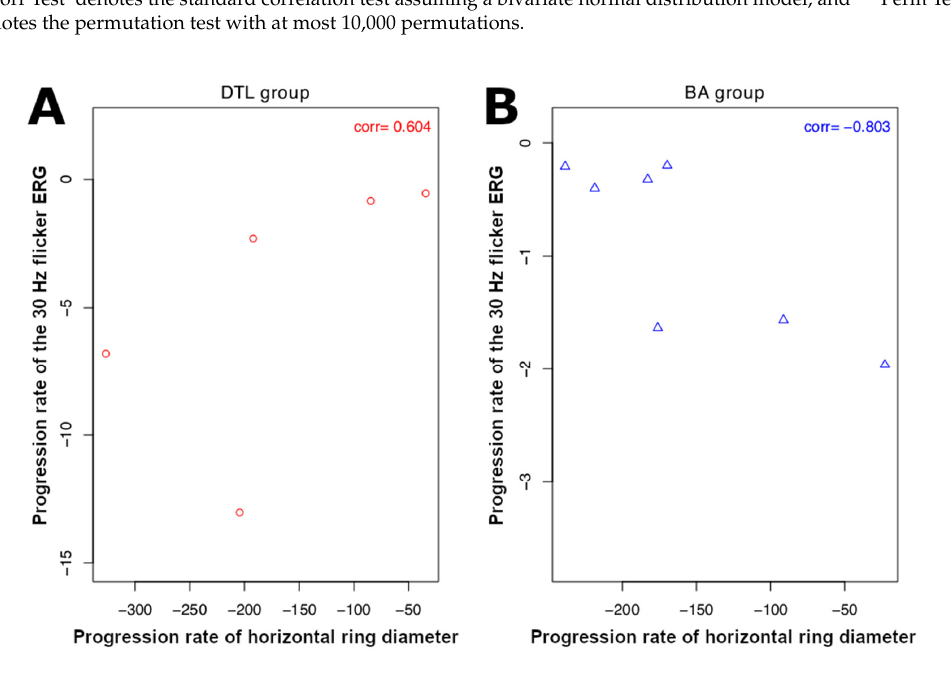
Figure 3. Scatter plots of the progression rate of 30 Hz flicker electroretinogram (ERG) amplitude versus that of vertical ring diameter: ( A ) progression rates of patients in DTL and ( B ) BA groups. Correlations between progression rates are not significant in either DTL or BA groups. Here 'corr' at the top-right corner of each subplot denotes correlation coefficient.